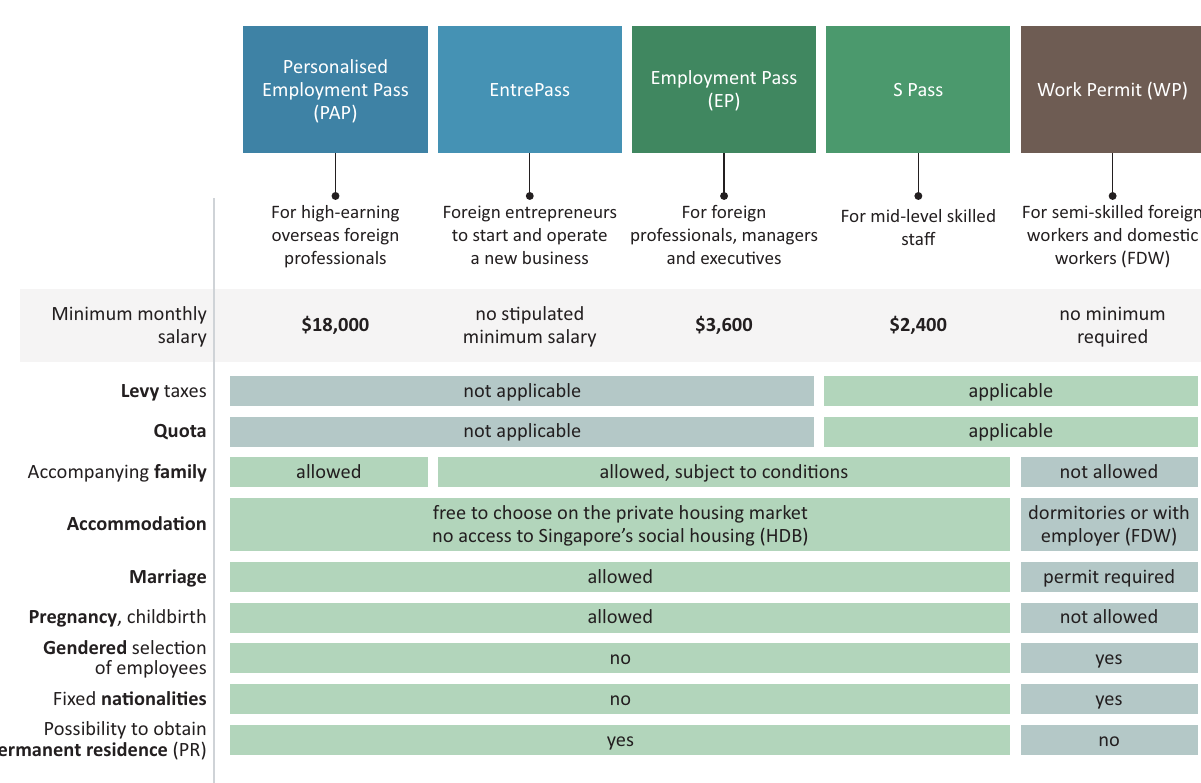
Figure 1. The main types of work passes and related freedoms in Singapore. Source: Own draft, based on Iwasaki (2015) and Ministry of Manpower of Singapore